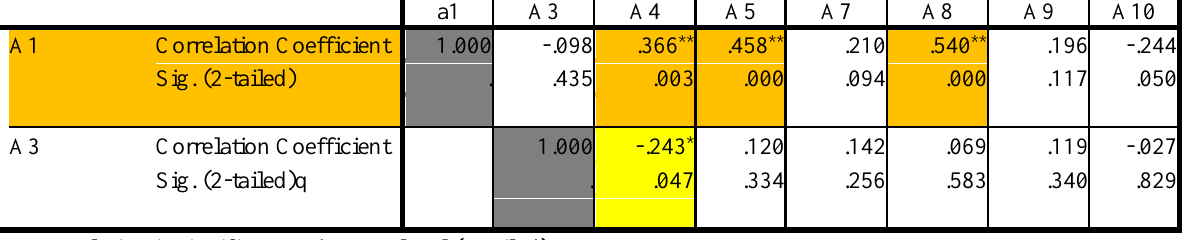
Table 2. Spearman Correlation between Gender, time of Usage and Fear of